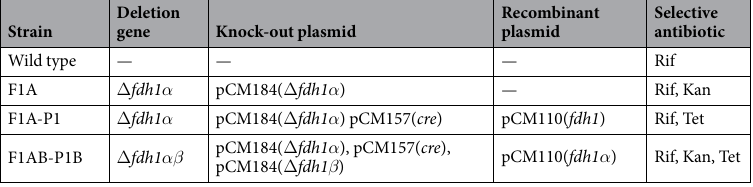
Table 1. Bacterial strains and their plasmids for knockout or for recombinant expression.